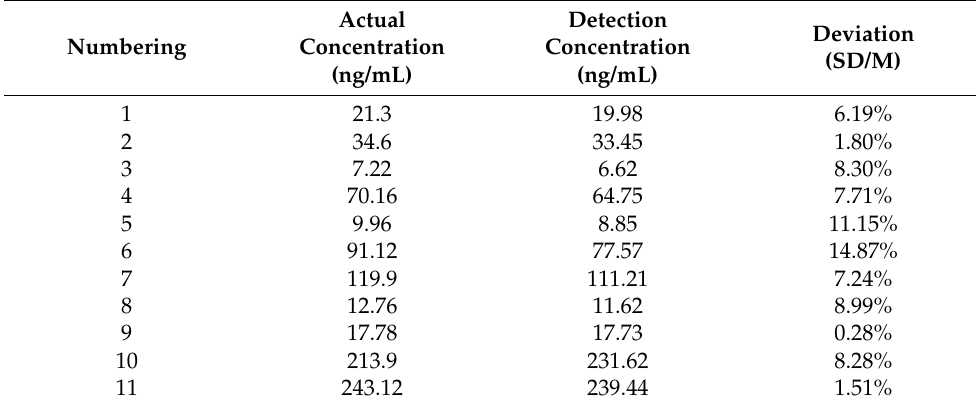
Table 2. Comparison of detection value and actual